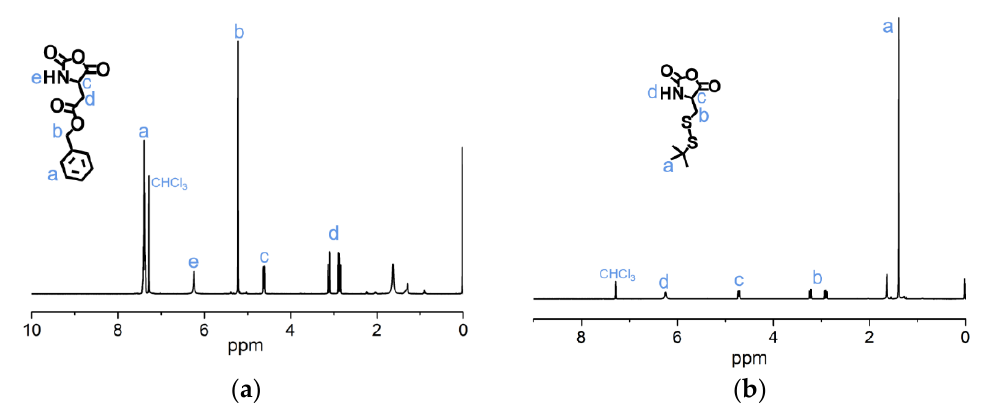
Figure 3. 1 H-NMR analyses of ( a ) BLA-NCA and ( b ) tBMLC-NCA in CDCl 3 . Figure 5. 1 H-NMR analyses of ( a ) mPEG-CHO and ( b ) mPEG-C=N-Alkyne in CDCl 3